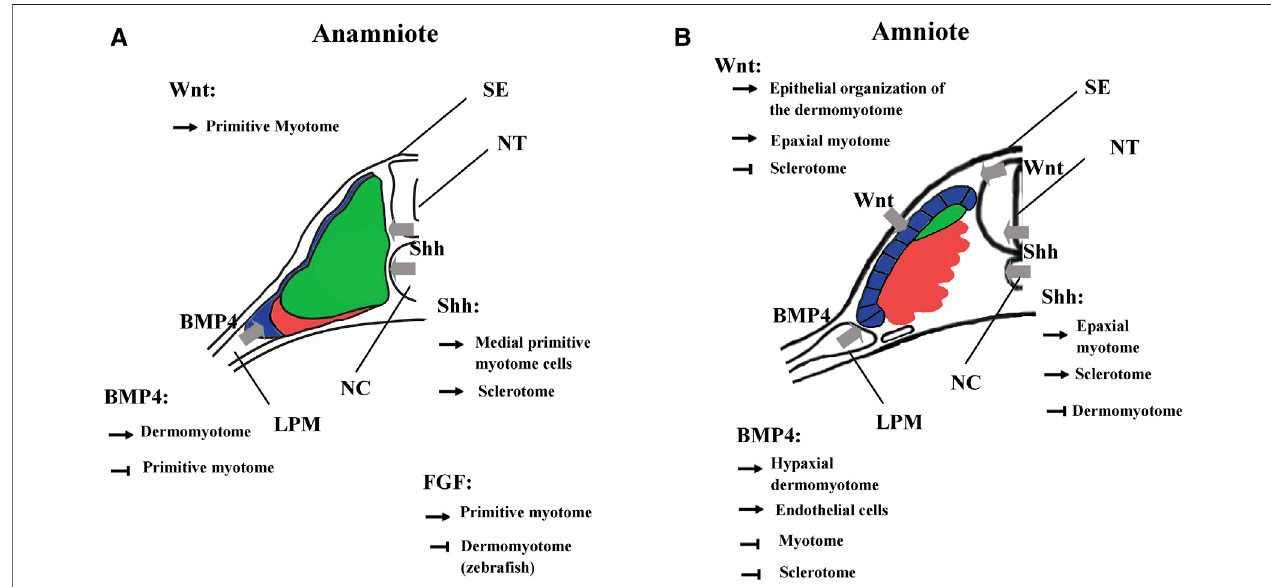
FIGURE 7 | Main functions of BMP, FGF, Wnt, and Shh signalings during somite compartmentalization in anamniotes (A) and amniotes (B) . Somite compartmentalization depends on signals expressed by surrounding tissues. Shh is expressed by notochord (NC) and fl oor plate, Wnt by surface ectoderm (SE) and dorsalneuraltube(NT)andBMP4bylateralplate mesoderm (LPM).Mostofthefunctionsful fi lledbythesignalingmoleculesseem tobeconservedbetweenanamniotes (A) and amniotes (B) . However, it seems that Fgf and to a lesser extent Wnt may play an early role in the formation of primitive myotome only in anamniotes (A) . Arrows, promoting effect; T-shaped line, inhibitory